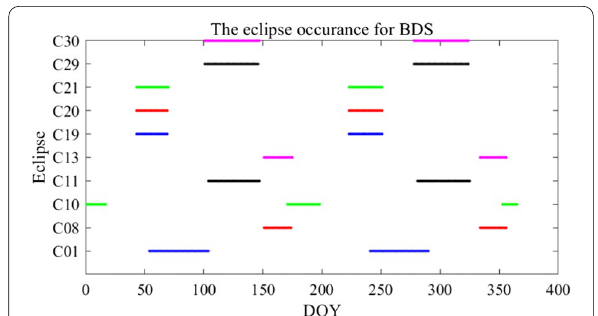
Fig. 5 Eclipse occurrence of BeiDou satellites in